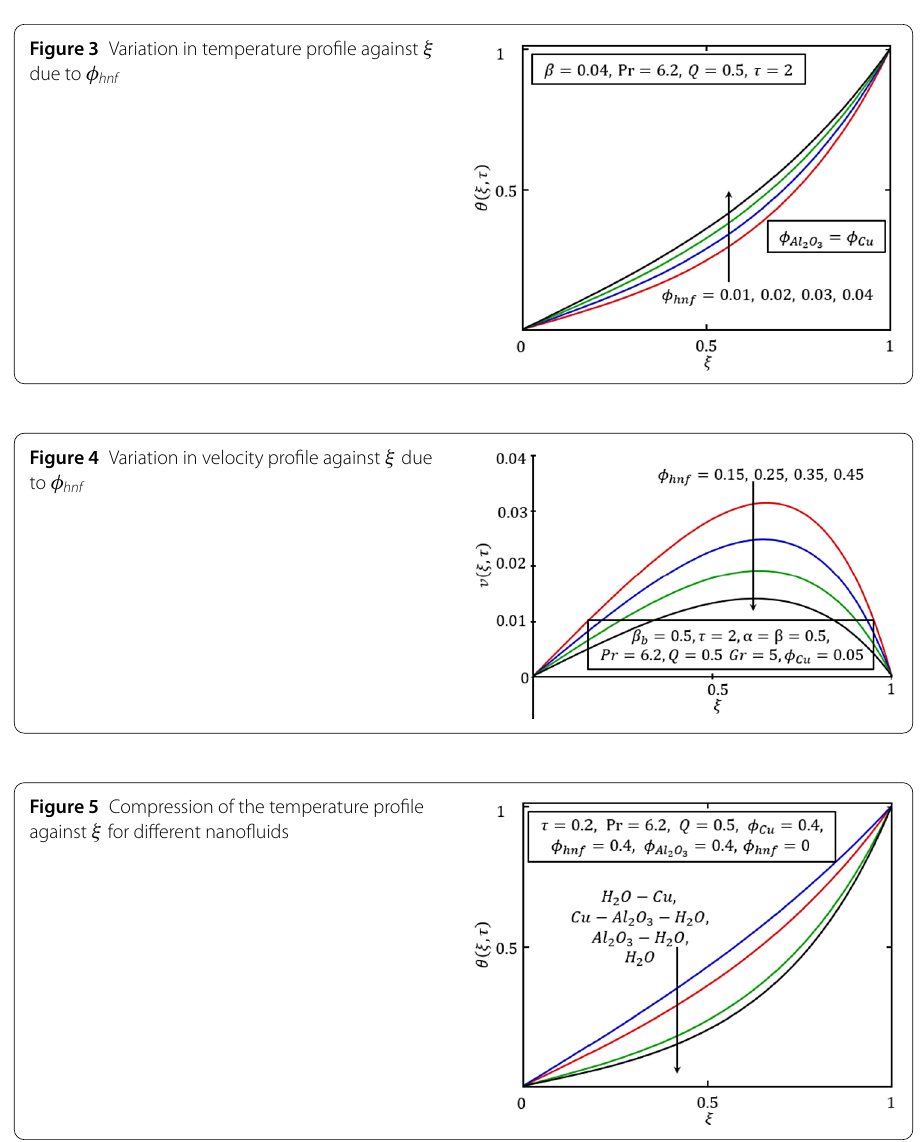
Figure 3 Variation in temperature profile against ξ due to φ hnf